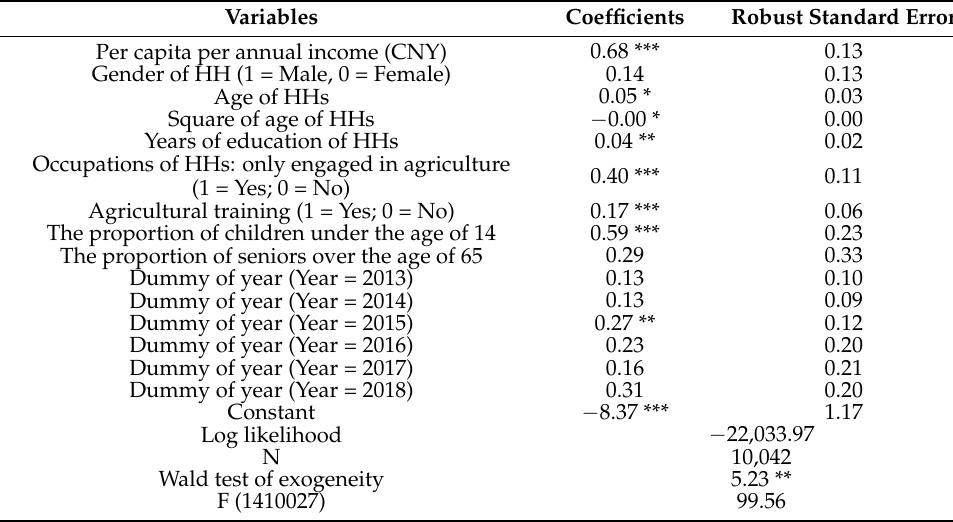
Table A1. The results of the IV-Probit model.